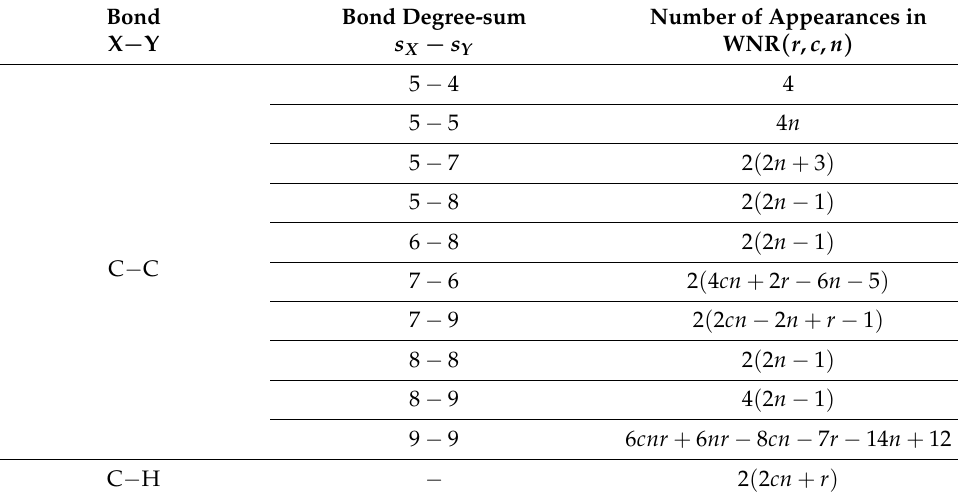
Table 4. Edge degree-sum partition of wave-like